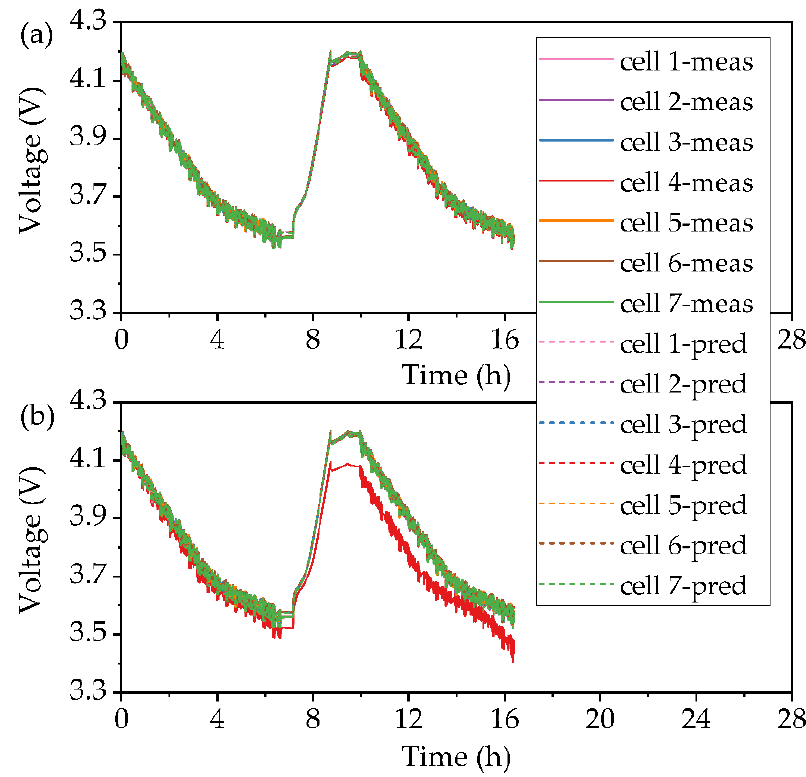
Figure 5. Voltage responses of each battery during: ( a ) 100 Ω -ER ISC test; ( b ) 10 Ω -ER ISC test.